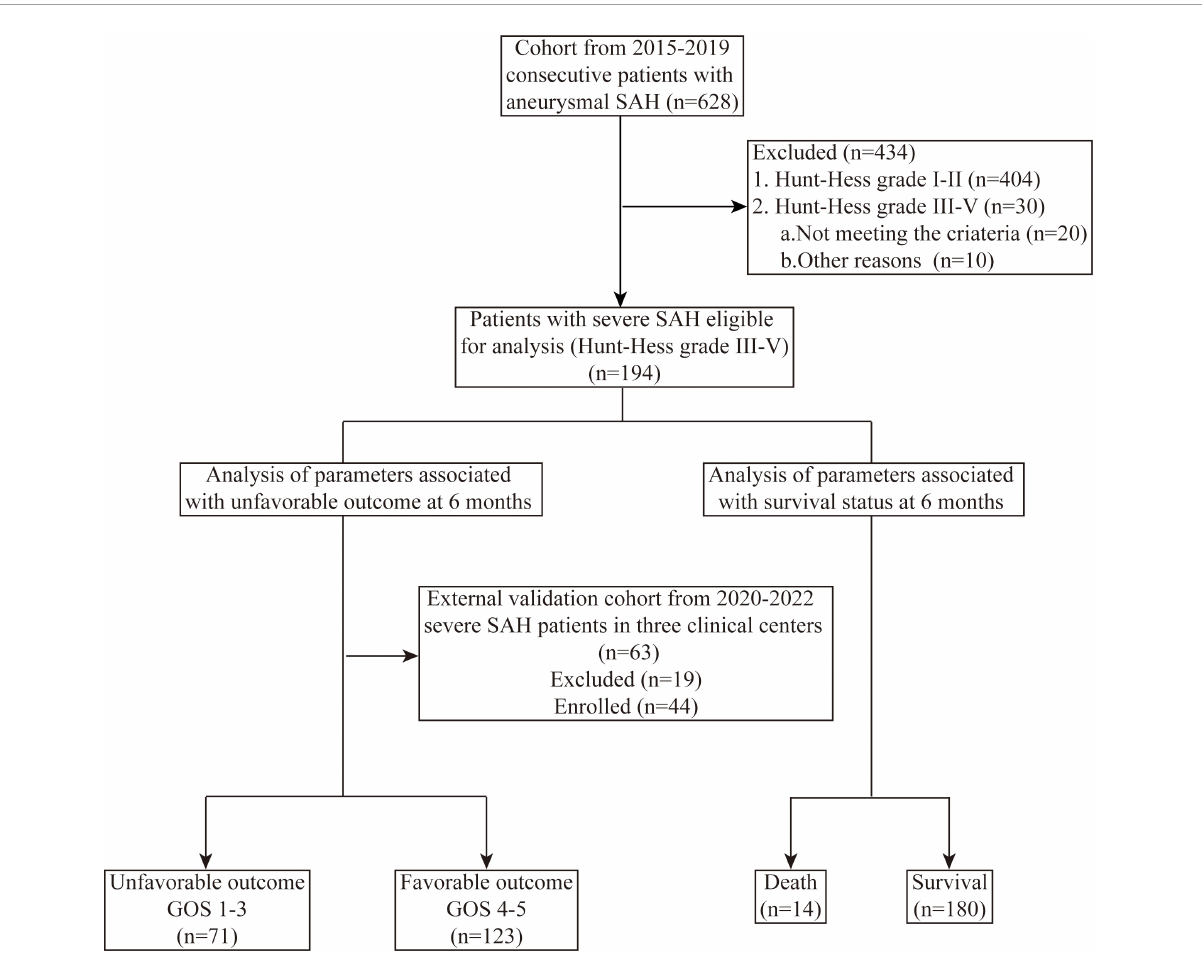
FIGURE1 Flowchart of patients’ selection and study process. SAH, subarachnoid hemorrhage; GOS, Glasgow outcome score.